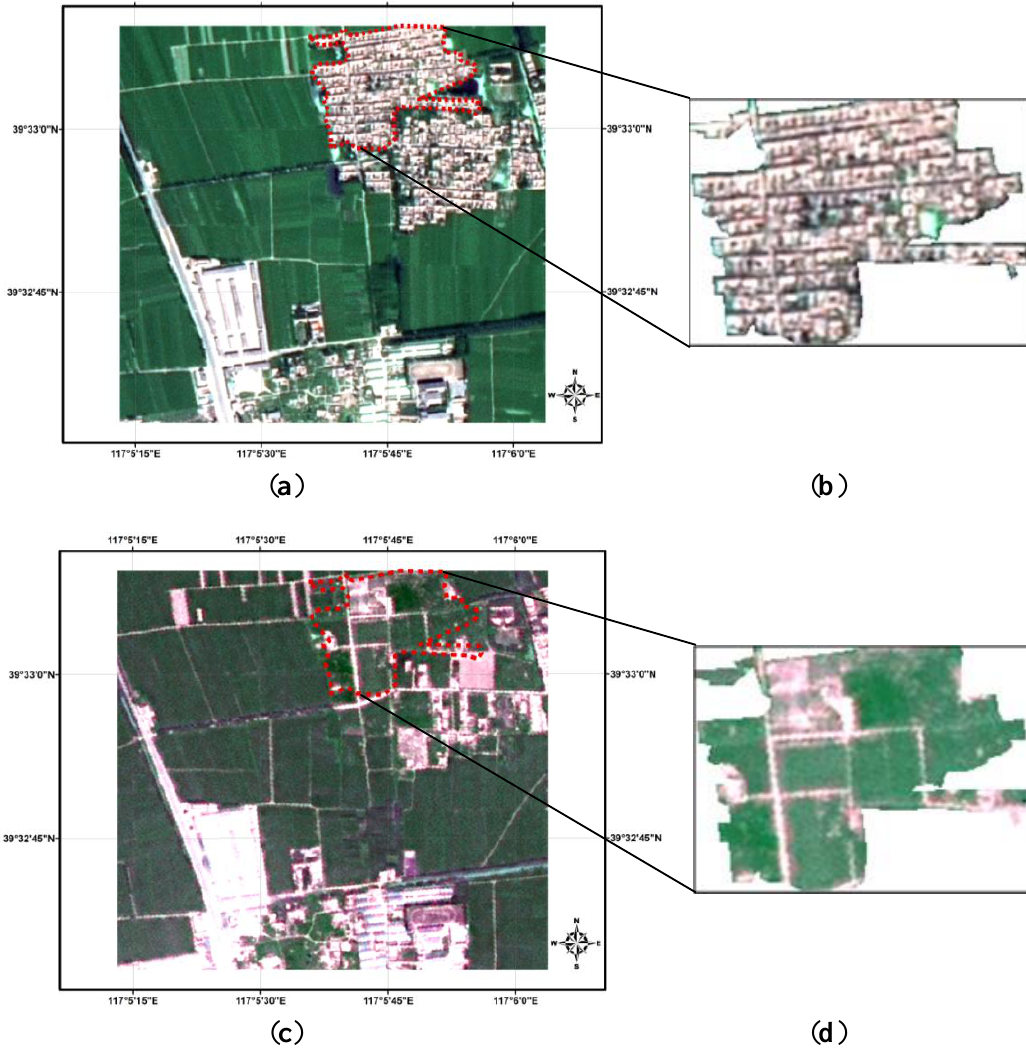
Figure 4. Example of change area. ( a ) Example area in t areas). ( c ) Corresponding area in t